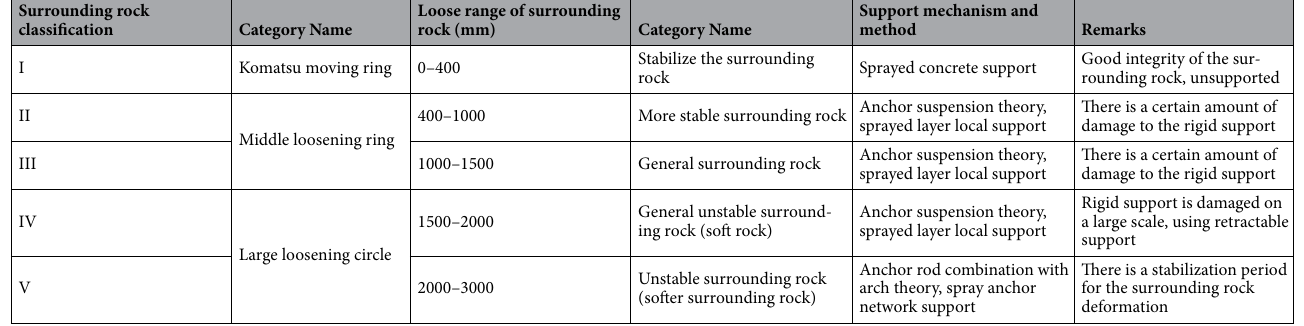
Anchored section of the surrounding